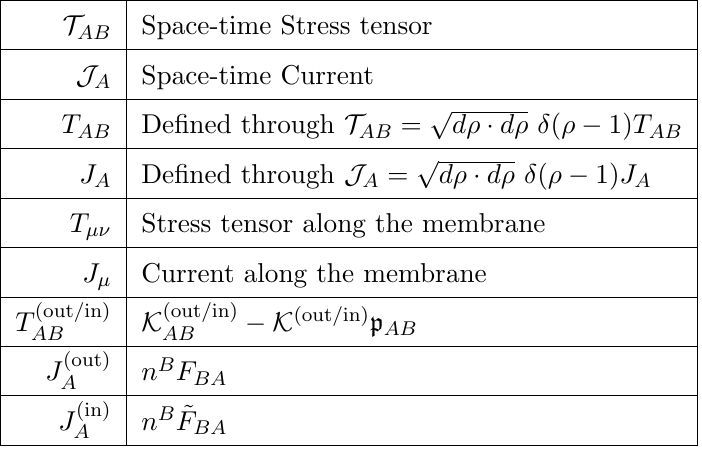
Table 9 . Di(cid:11)erent Sources.